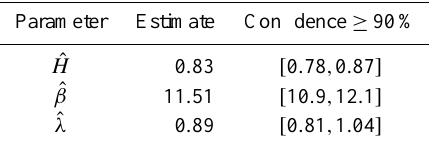
Table 2. Confidence intervals on the estimated parameters.